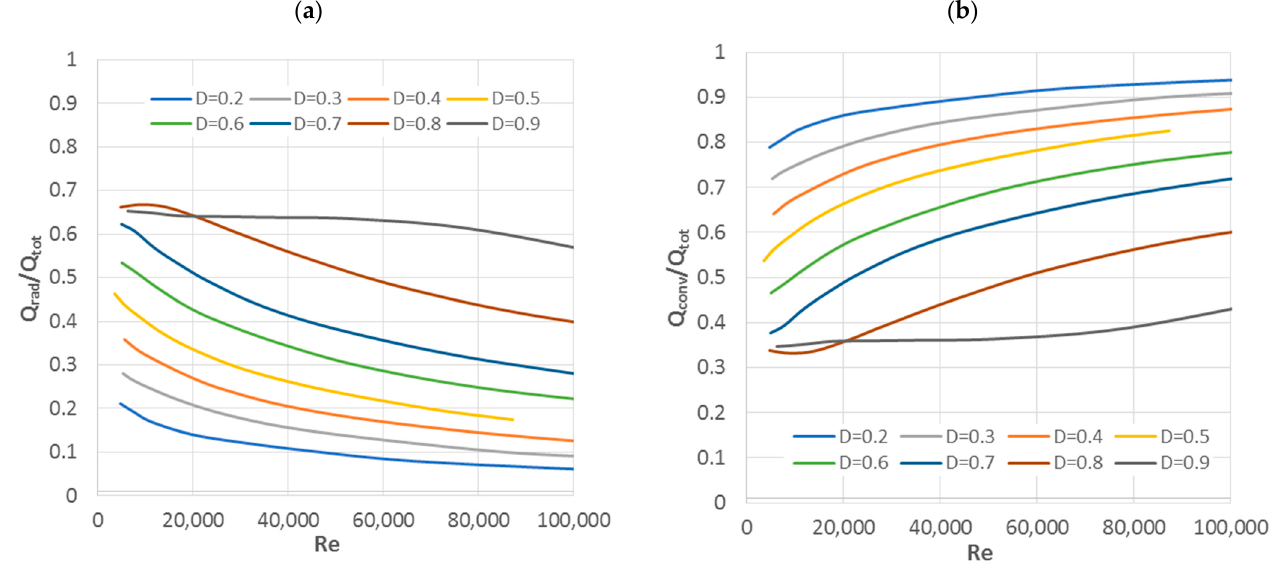
Figure 6. Fractions of radiative ( a ) and convective ( b ) heat fluxes in the total heat flux at the pipe wall.